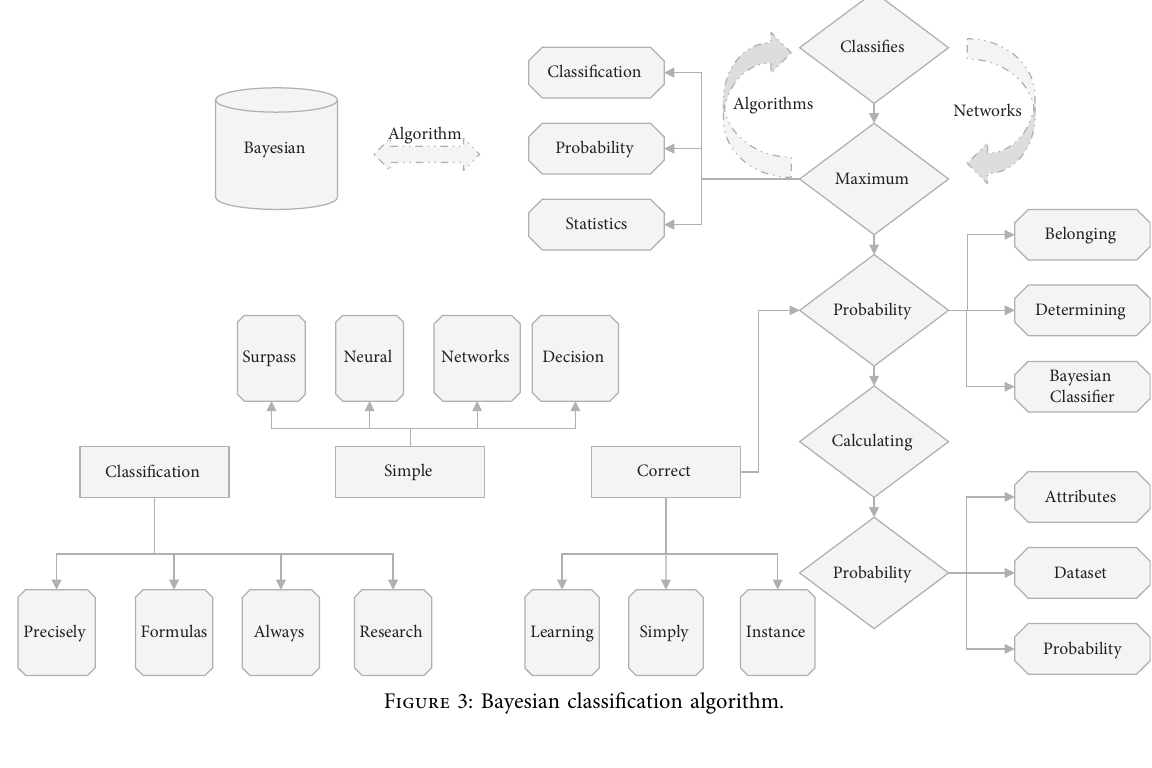
Figure 3: Bayesian classification